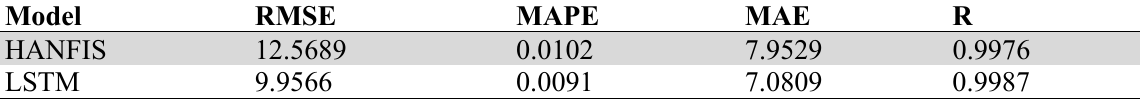
Performance statistics of HANFIS and LSTM